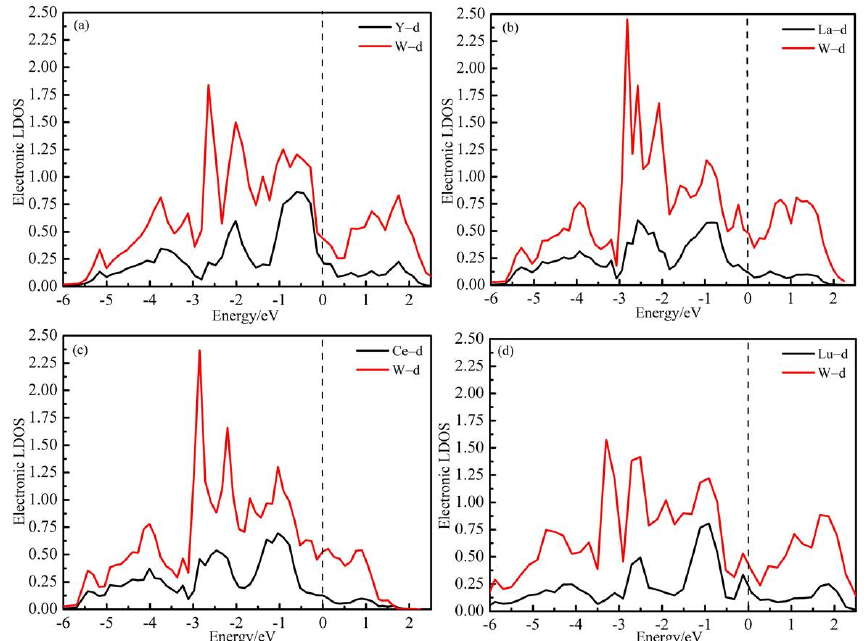
Figure 9. The local electronic densities of states (LDOS) of W and M atoms in bcc W 1 − x M x alloys, ( a ) W 0.875 Y 0.125 alloy, ( b ) W 0.875 La 0.125 alloy, ( c ) W 0.875 Ce 0.125 alloy ( d ) and W 0.875 Lu 0.125 alloy. The red lines are the LDOS of W nearest neighbors to M and black lines are the LDOS of M. The Fermi level was set as zero.